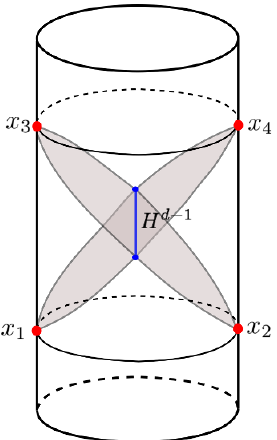
Figure 1 . Scattering kinematics. The red dots mark origins of the four Poincare patches. Each operator is inserted in the vicinity of the corresponding origin with the wavefunction which is a plane wave. The scattering occurrs in H d − 1 which is marked by a blue line. It stands for the intersection of two Poincare horizons which are depicted in shaded gray. Each Poincare horizon is generated by future or past null geodesics emanated from points x i